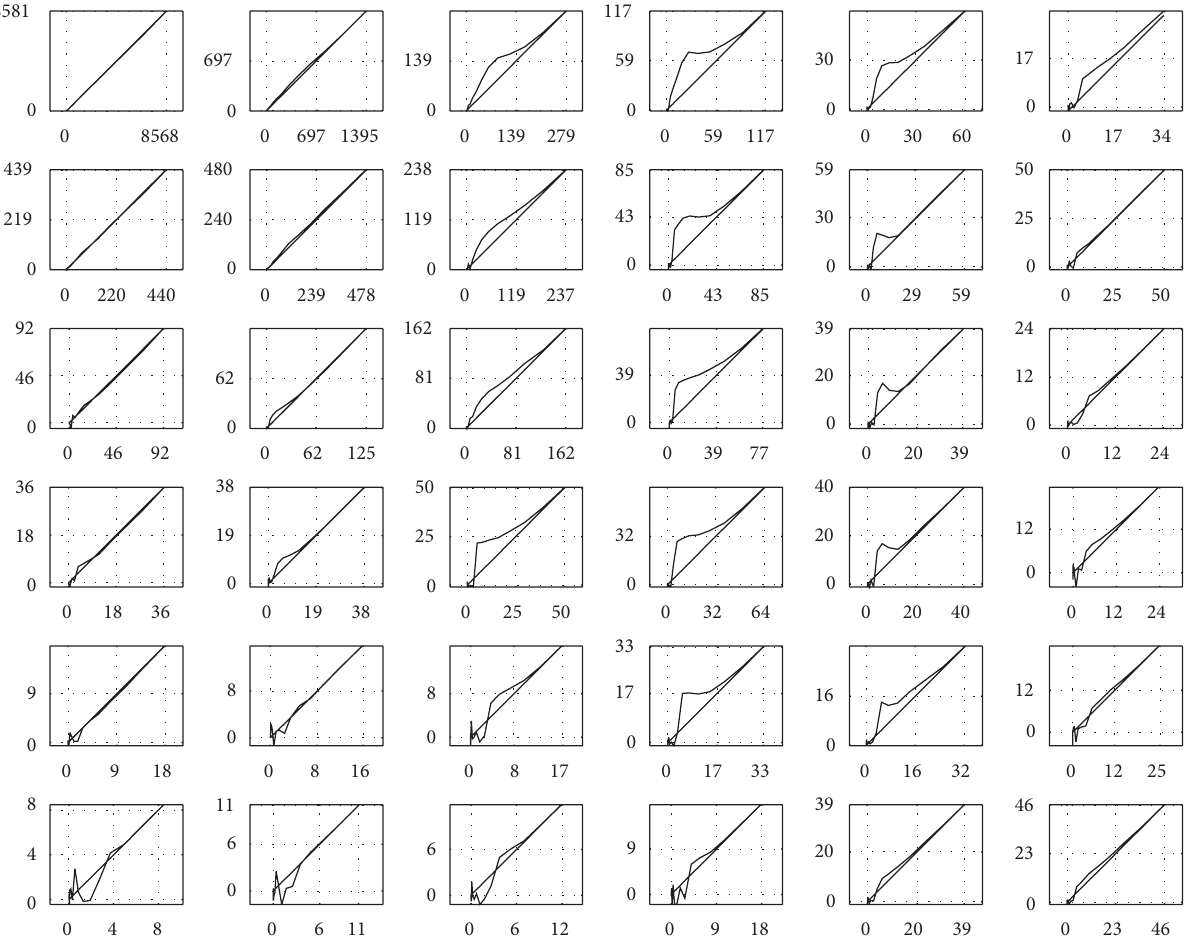
Figure 4: Shrinkage functions obtained via the learning process on a training set consisting of male thighs images. Only the odd rows and columns from the original 11 × 11 array of functions are displayed due to space considerations. Due to the antisymmetry, only the positive half of the 𝑥 -axis is